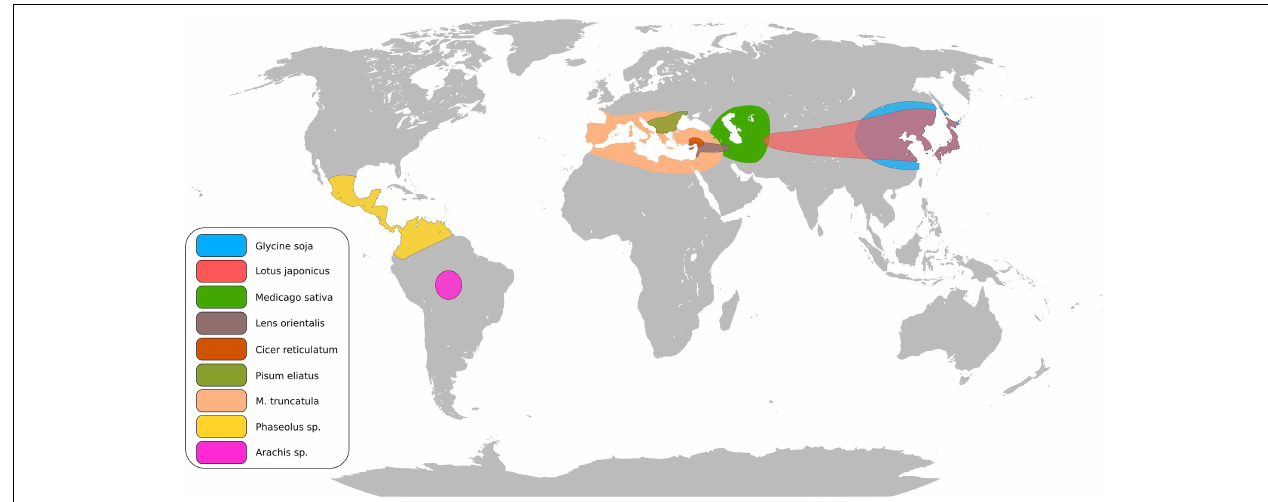
FIGURE 1 | Putative centers of origin of major legume crops and model